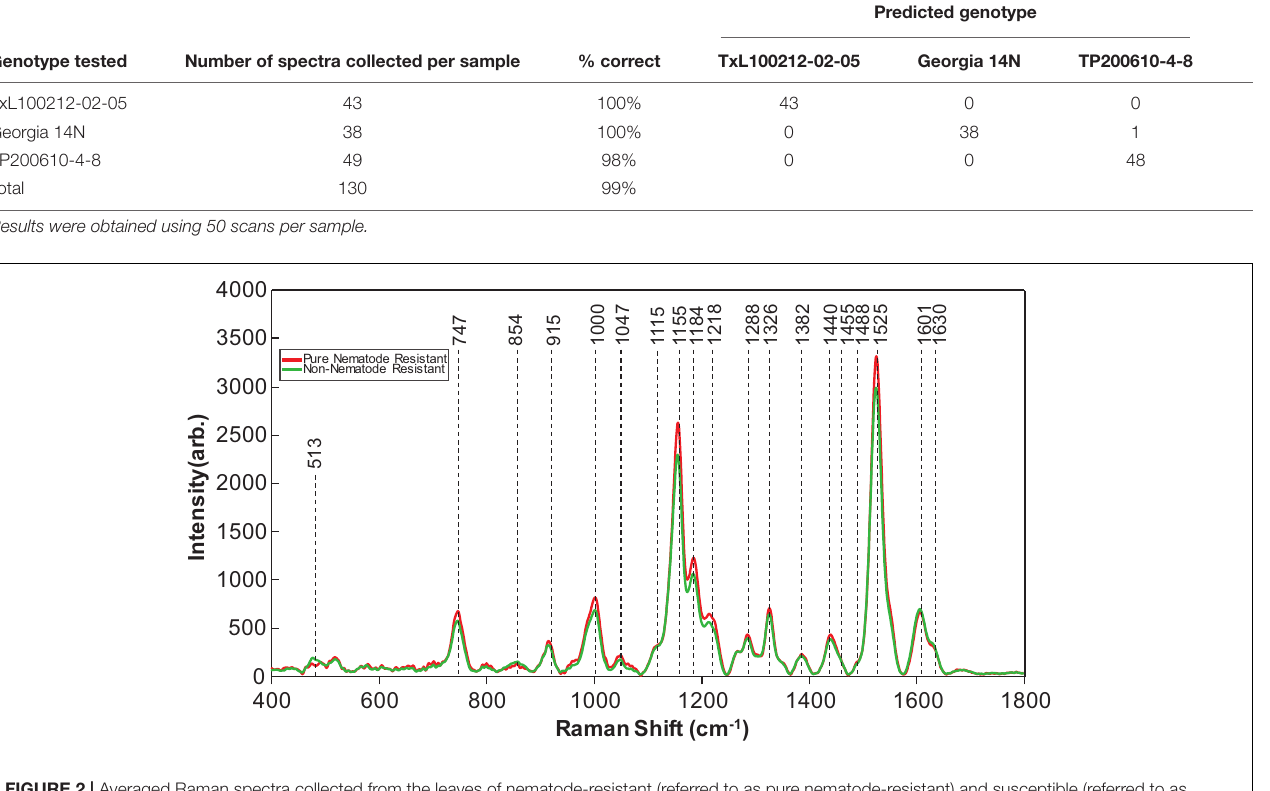
FIGURE 2 | Averaged Raman spectra collected from the leaves of nematode-resistant (referred to as pure nematode-resistant) and susceptible (referred to as non-nematode-resistant) peanut